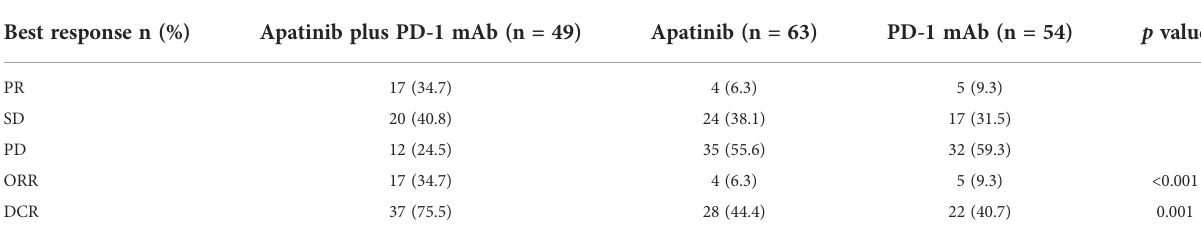
TABLE 2 Overall